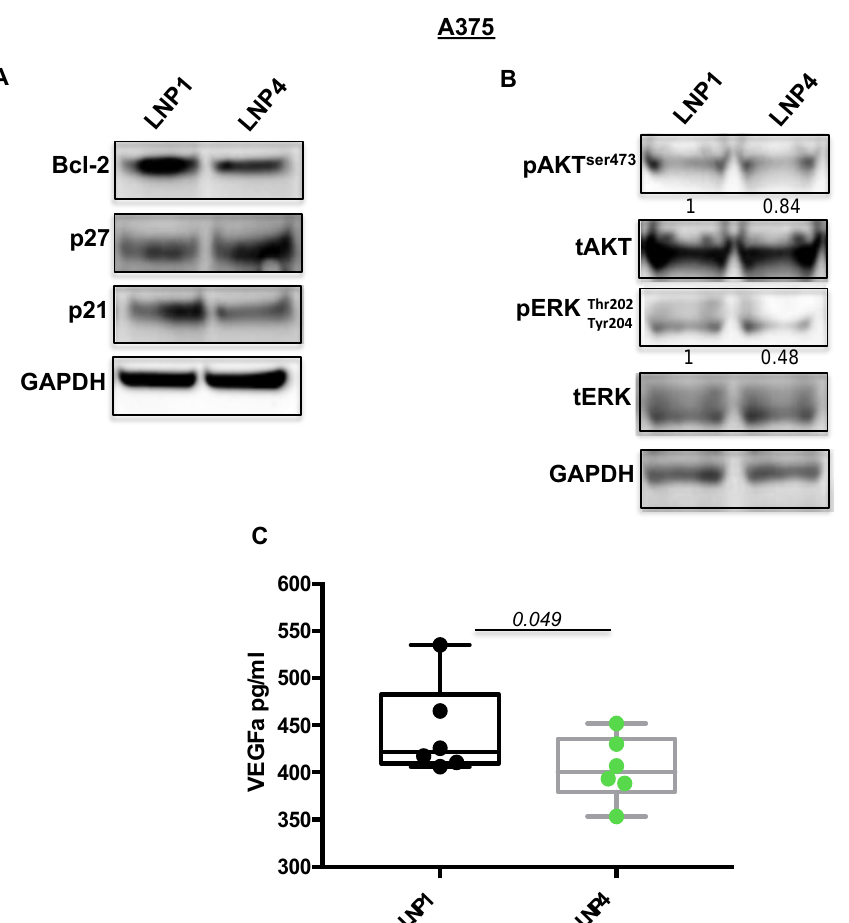
Figure 3. LNP4 affects different downstream effectors in response to the upregulation of miR-204-5p and miR-199b-5p. ( A and B ) A375 cells were treated with LNP1 or LNP4, as described above, and total protein extracts were subjected to Western blot analysis to measure the expression levels of the indicated molecular effectors downstream of miR-204-5p and miR-199b-5p. ( C ) ELISA-based reading was used to determine the levels of soluble VEGF-A in response to LNPs treatments in A375 cells.